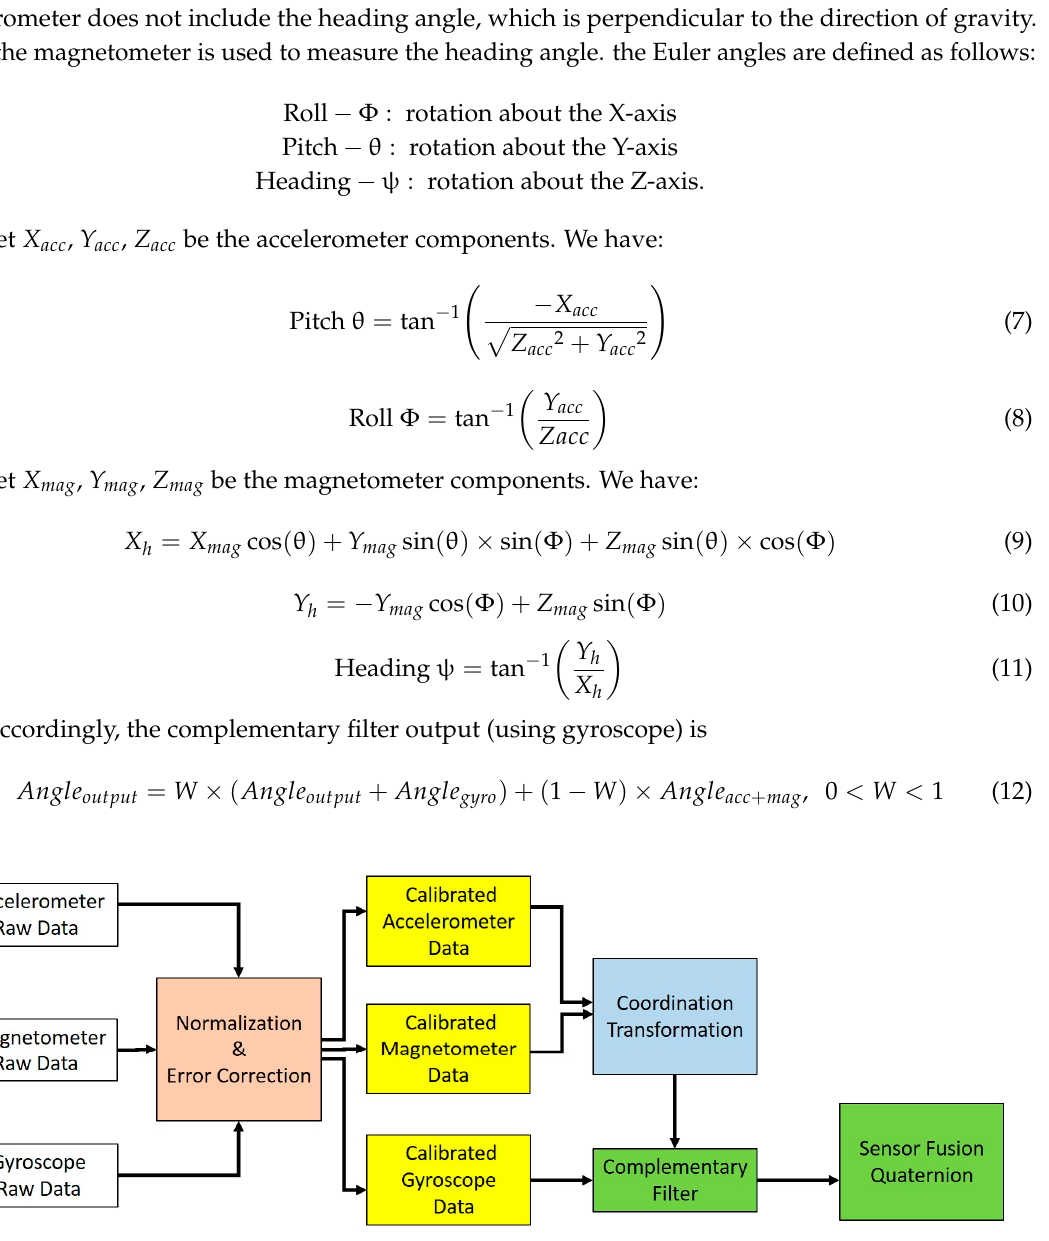
Figure 9. The diagram shows the process of sensor fusion.